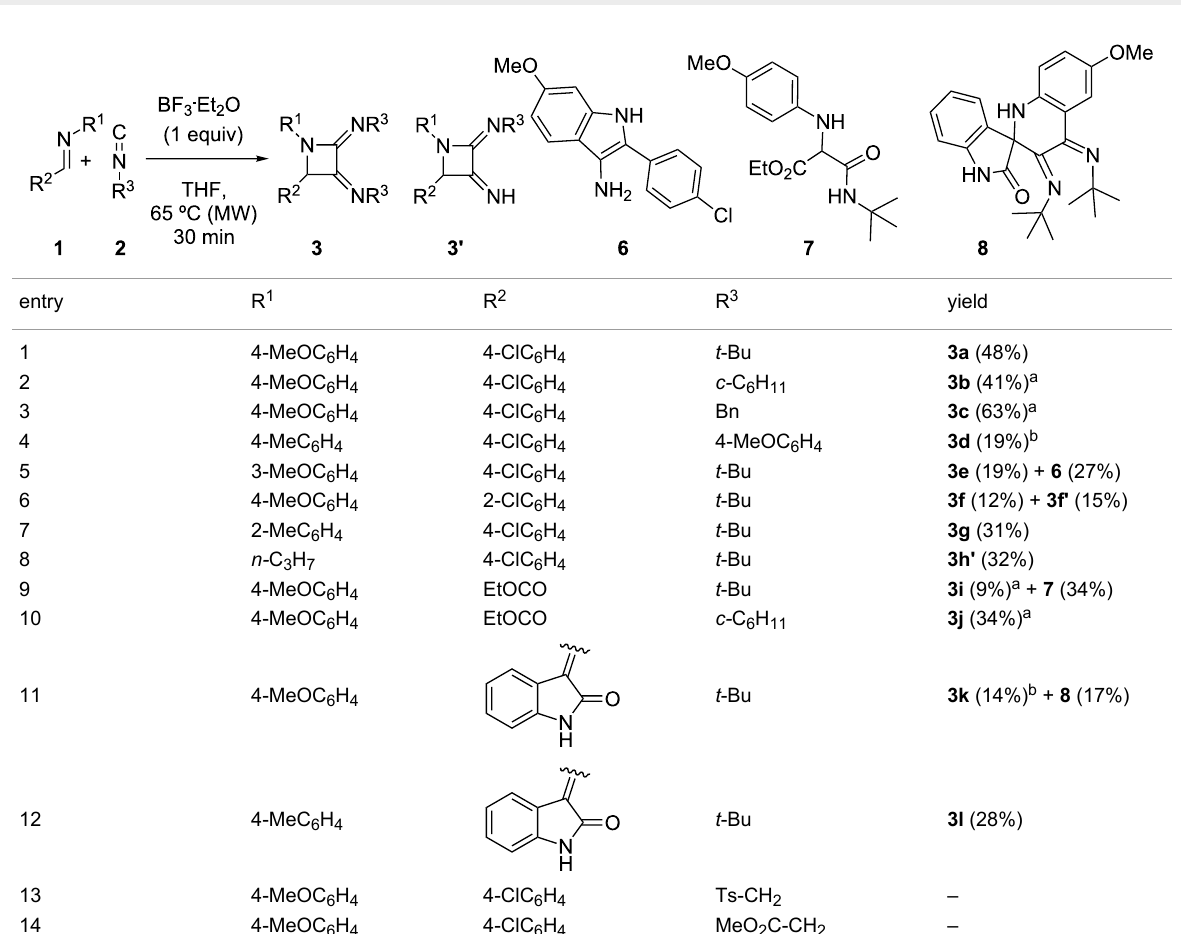
Table 1: Scope of the imine and isocyanide starting